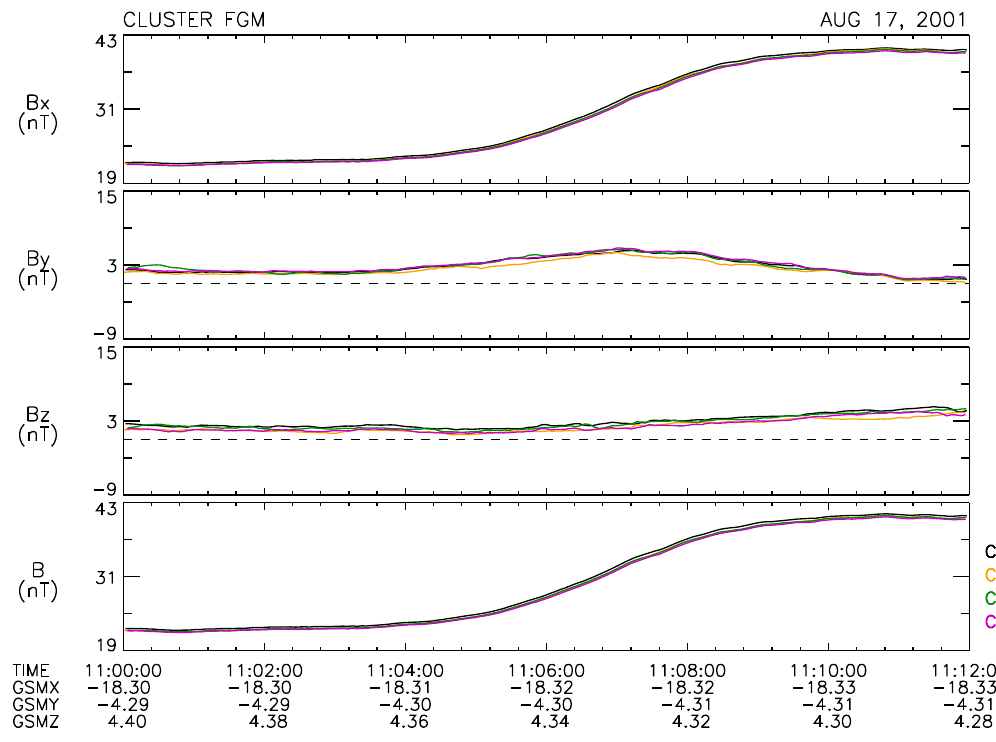
Fig. 4. Fine scale plot of the tail lobe SI presented in Fig. 3. Panels show the magnetic field components in the GSM coordinate system and the magnetic field